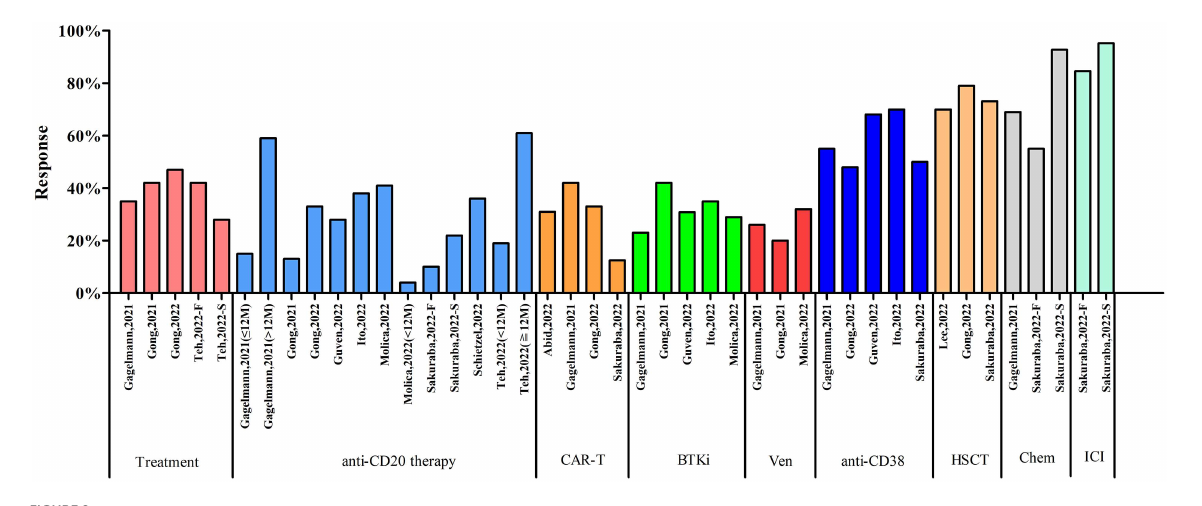
hematological malignancies. These results were shown in Figure 5.